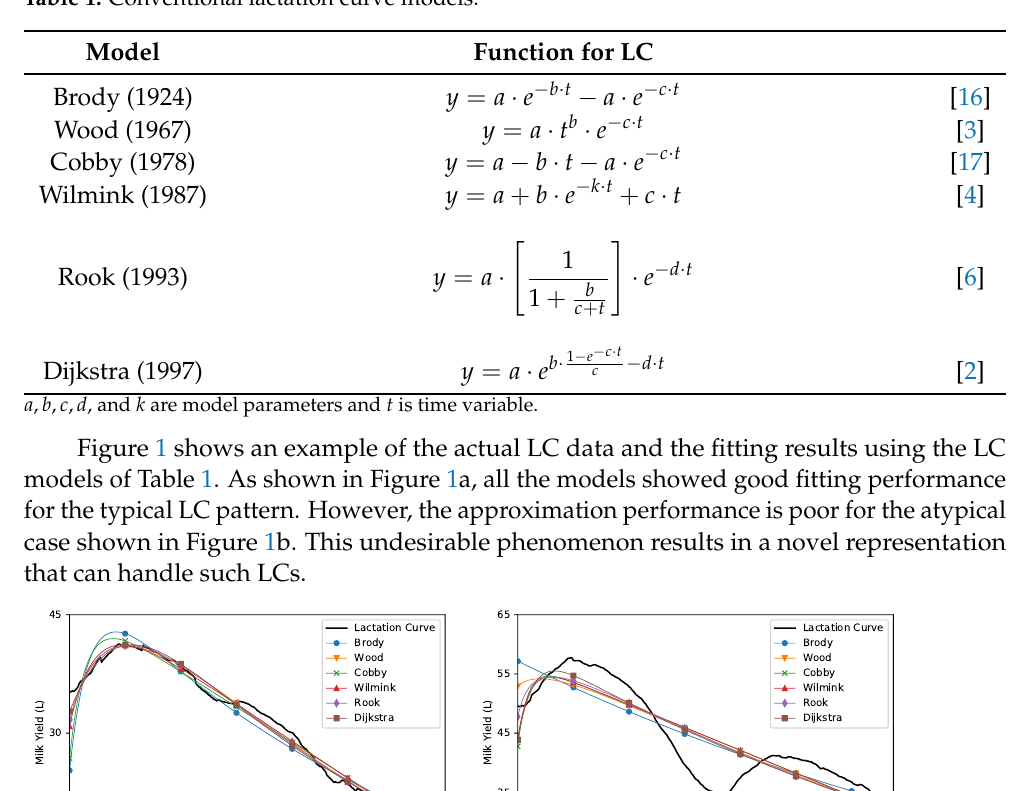
Table 1. Conventional lactation curve models.